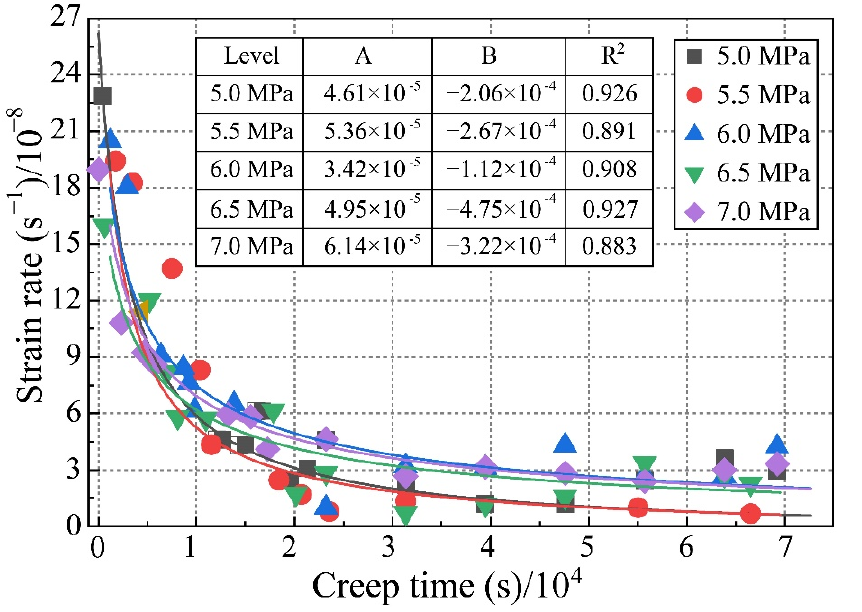
Figure 5. Strain rate curve and fitting results.